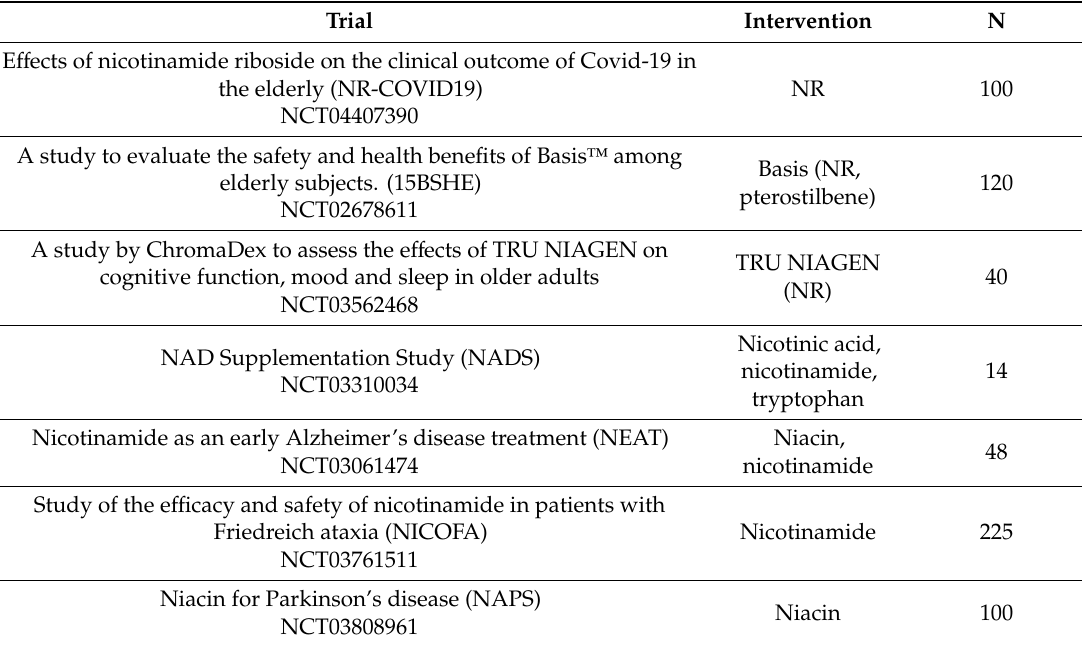
Table 2. Cont. Trial Intervention